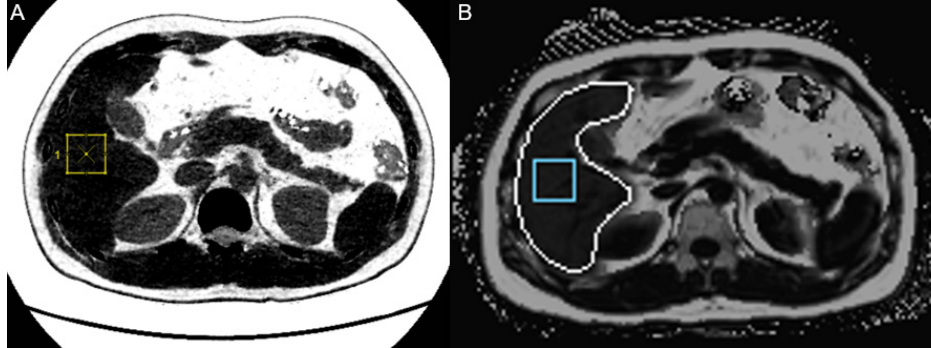
Figure 4. An example of fat quantification using ( A ) an FVF map and ( B ) MRI-PDFF in a 33-year-old man with fatty liver (MRI-PDFF = 6.5%). The FVF map yielded a value of 5.2%.